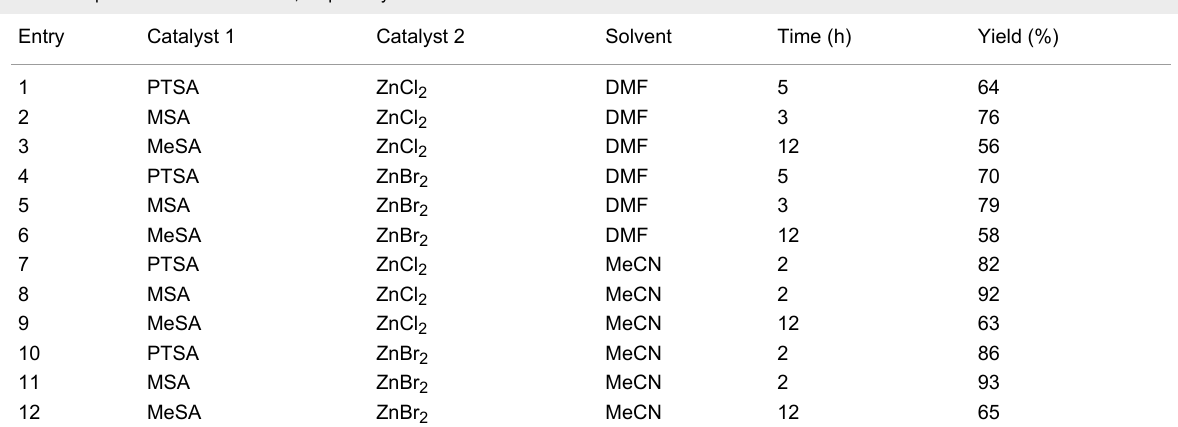
Table 1: Optimal conditions for the 1,3-dipolar cycloaddition route. a